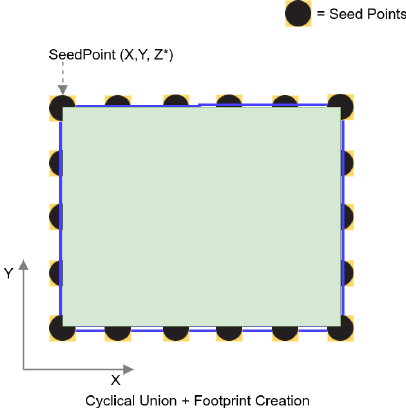
Figure 9. Footprint creation of the